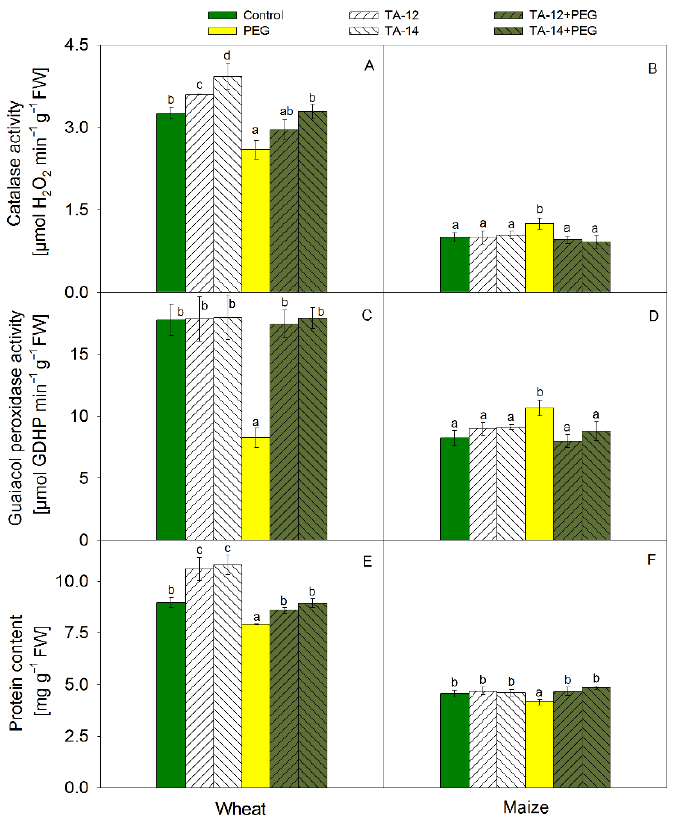
Figure 4. Activities of catalase (CAT; A , B ) and guaiacol peroxidase ( C , D ), and protein content ( E , F ) in shoots of wheat ( A , C , E ) and maize ( B , D , F ) foliar sprayed with 1 mM TA-12 or TA-14 and subjected to 10% PEG for 72 h. Data are mean values ± SE. Different letters designate a statistically significant difference at p < 0.05.